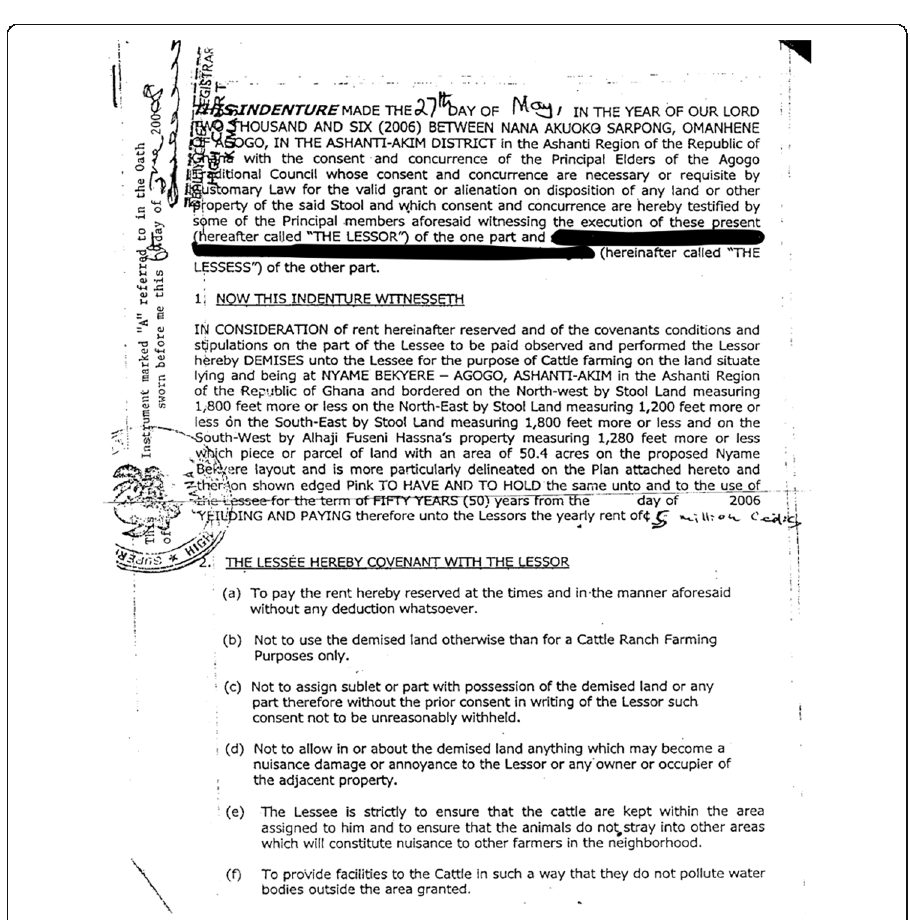
Fig. 2 Excerpt statutory lease agreement between herders and the Agogo Traditional Council. Source: Deed of Lease